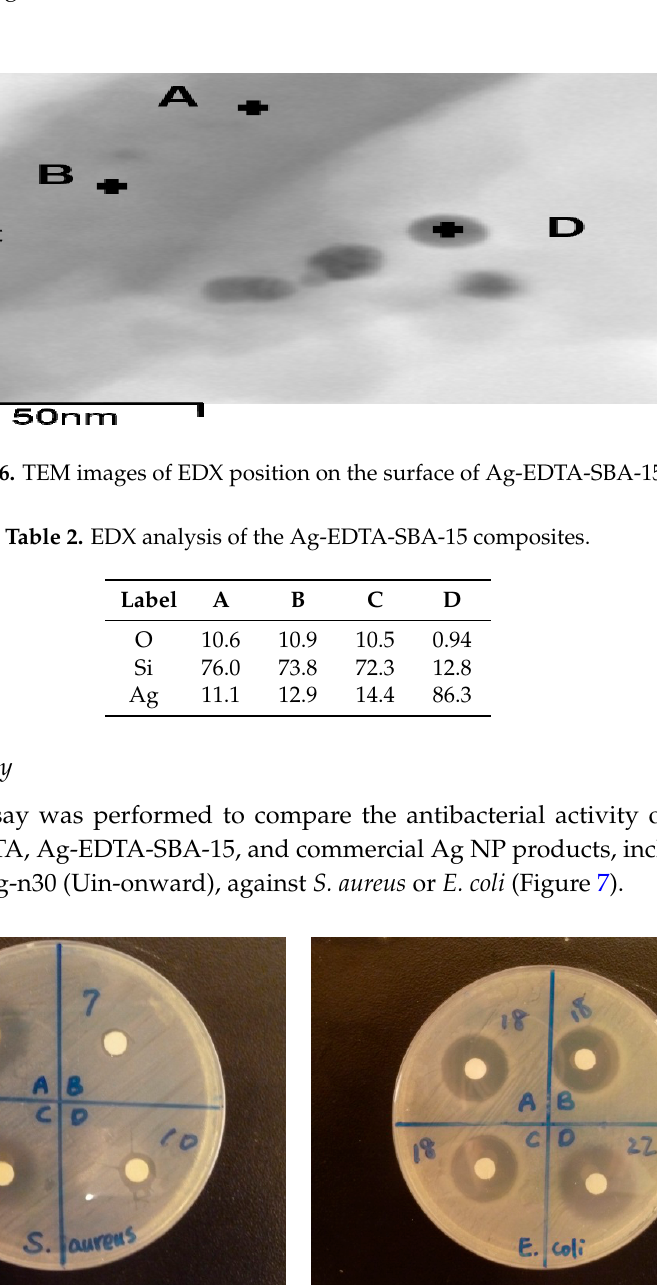
Figure 7. Pictures of the disc diffusion assays: ( a ) Staphylococcus aureus ( b ) Escherichia coli . The numbers next to the discs are the diameter (mm) of the inhibitory zones.